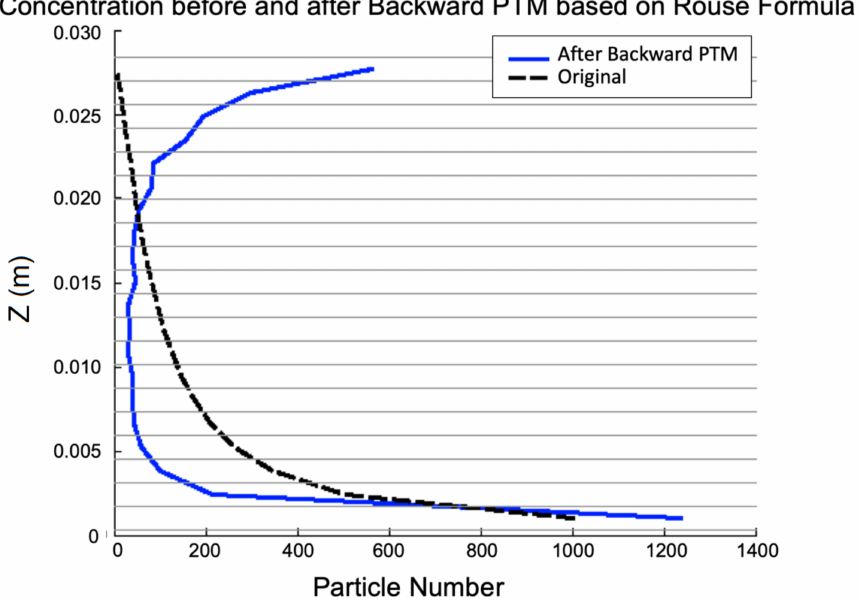
Figure 10. Sediment concentrations before and after backward PTM based on Rouse’s formula, represented as particle